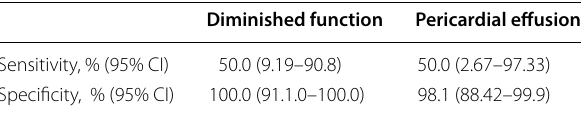
Table 4 Performance metrics of real-time interpretation of FOCUS (Phase 1)